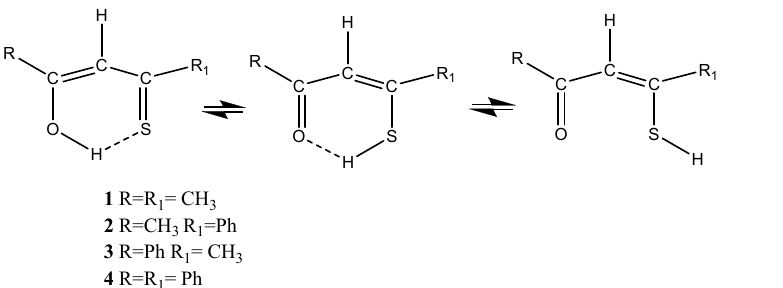
Scheme 2. Tautomers of β -thioxoketones plus the open form.